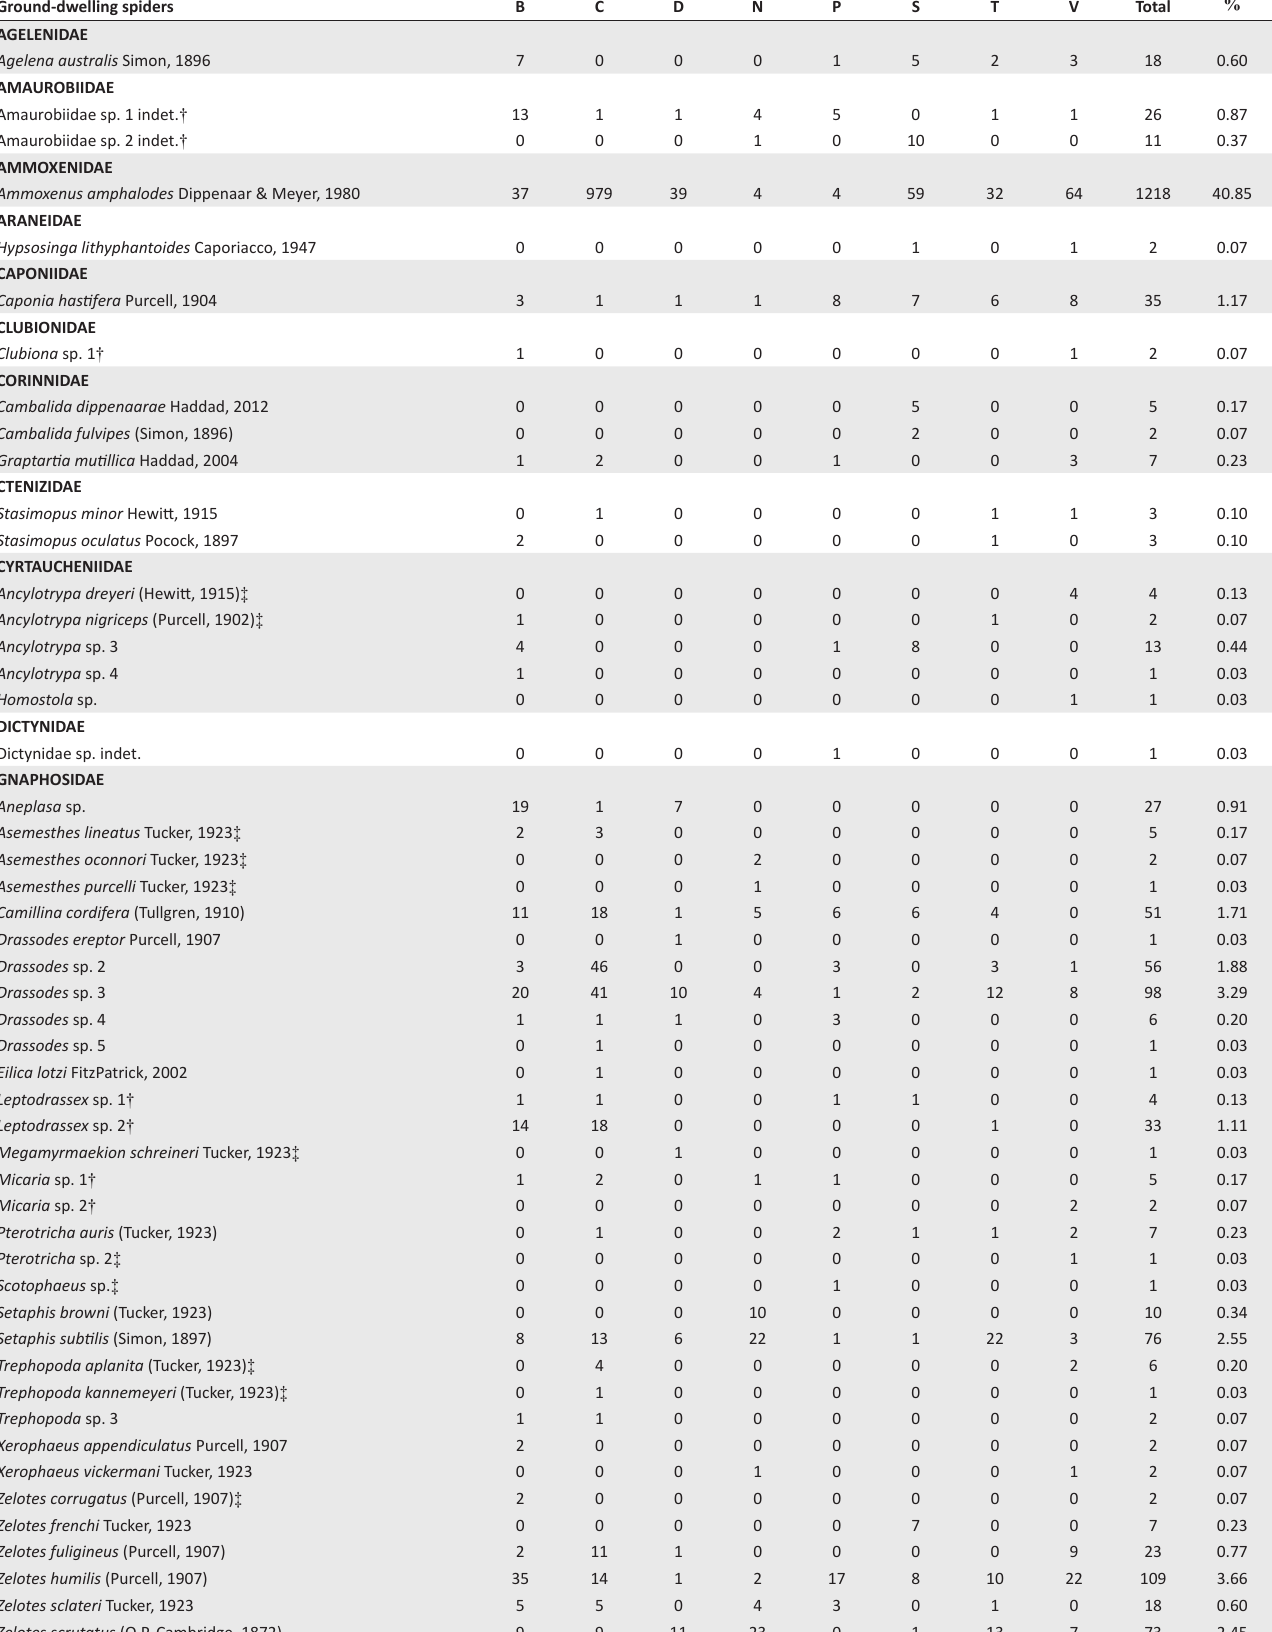
TABLE 1-A1: Ground-dwelling spiders collected by pitfall trapping from eight habitats in the Amanzi Private Game Reserve. Ground-dwelling